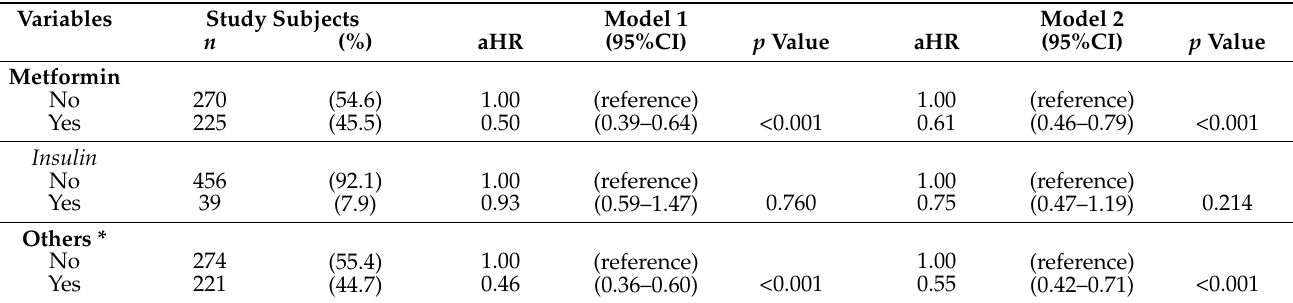
Table 2. Overall survival for study subjects according to diabetic